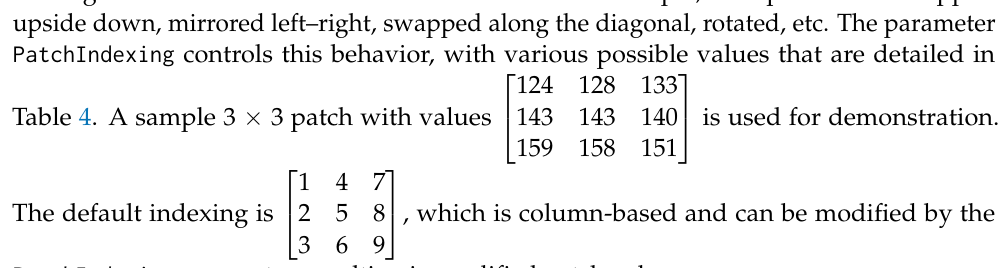
Table 4. A sample 3 × 3 patch with values